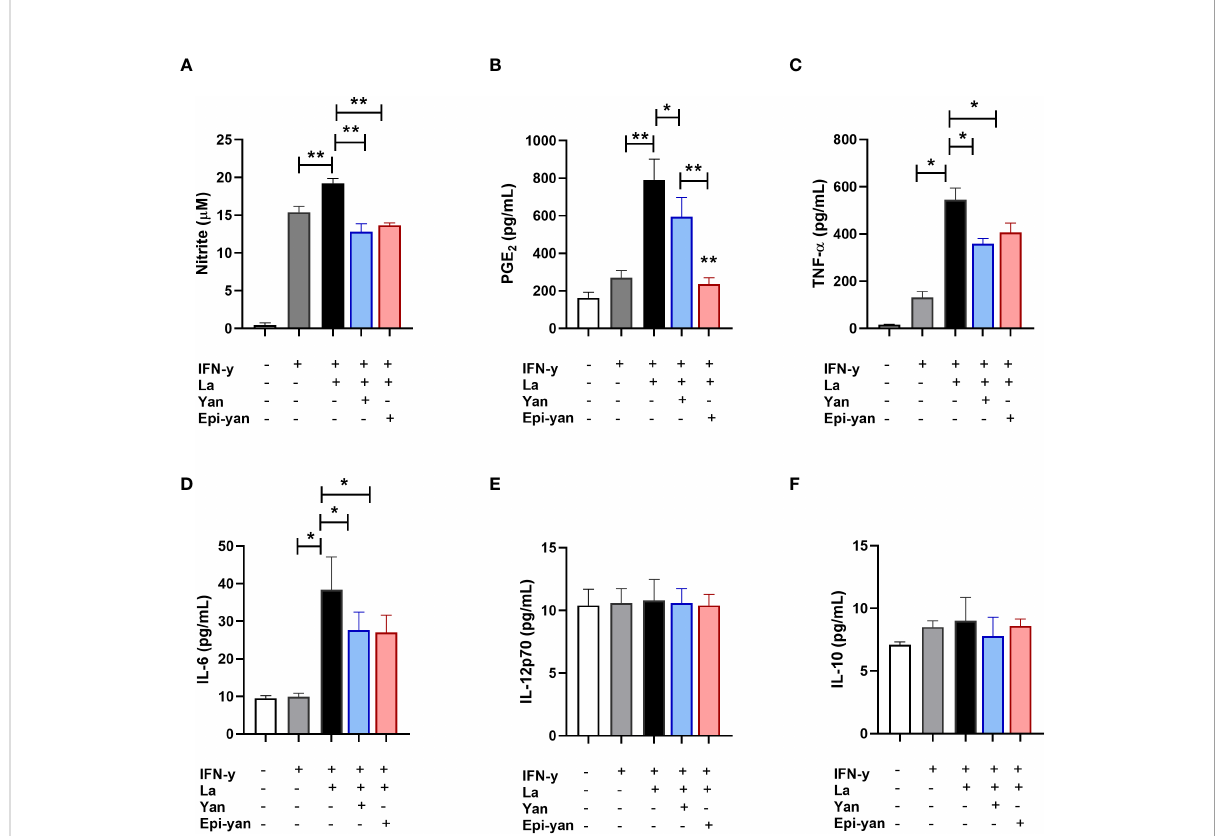
FIGURE 4 Immunomodulatory effects of yangambin and epi-yangambin on L. amazonensis -infected macrophages. Mediators were analyzed in the supernatants of cultured BMDM previously stimulated with IFN- g , then infected with L. amazonensis , followed by treatment with yangambin or epi-yangambin (100 µM) for 48h, as described in Materials and Methods . (A) Nitrite, (B) PGE2, (C) TNF- a , (D) IL-6, (E) IL-12p70 and (F) IL-10. Bars represent ±SD of a single experiment performed in quintuplicate. The Kruskal-Wallis test, followed by Dunn's post-test, was used for multiple comparisons, while the Mann-Whitney test was used for comparisons between two groups (*p < 0.05 and **p < 0.01). La, Leishmania amazonensis ; Yan, yangambin; Epi-yan,